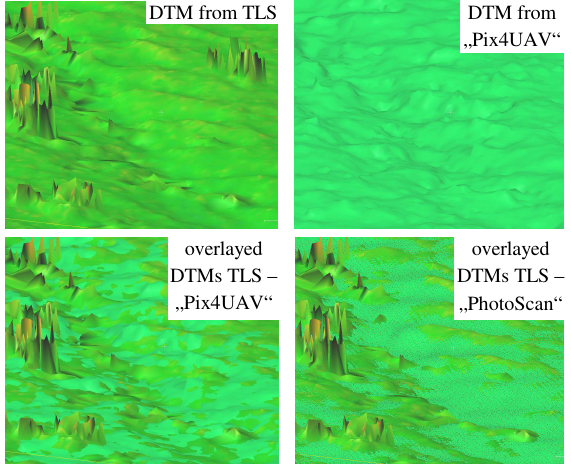
Figure 5. Occlusion effects within TLS data (green) compared to DTM generated from UAV point of view